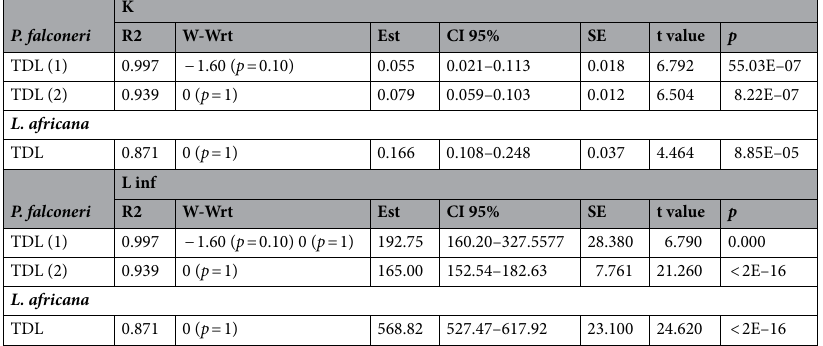
Table 1. Statistical results from von Bertalanffy growth model for diaphyseal length of the tibia (DL) of P. falconeri and L. africana . Considering that in the case of P. falconeri , the equation (model 1) only includes data from a segment of the ontogeny that covers the period from birth until the recorded age (growth cessation, 23 years in our P. falconeri sample), we provided a second model (model 2) based on the measured ontogenetic trajectory of tibiae (model 1) plus the minimum longevity inferred for P. falconeri from the longest available tusk to make the VBGM of both taxa comparable (See “Materials and methods”; Table 3; Supplementary material 3, 4).